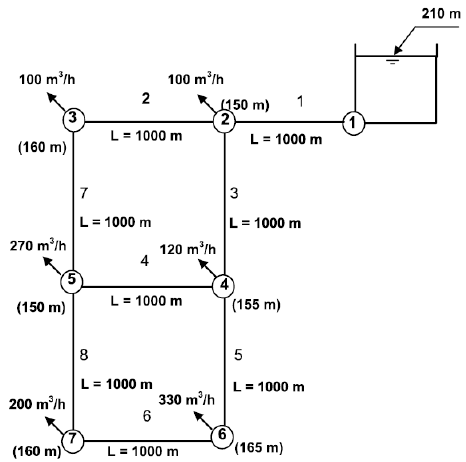
Figure 2. Layout of the Alperovits and Shamir network [3].